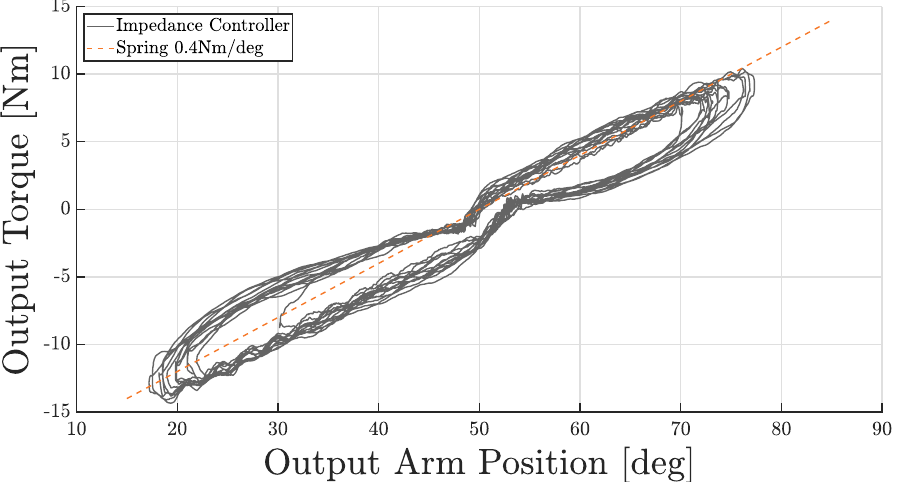
Figure 19. Impedance controller realised with the SMARCOS. The controller simulates a spring of stiffness 0.4 Nm/deg, acting around the centre point of the ball-screw axis, which corresponds to approximately ϑ = 50°.